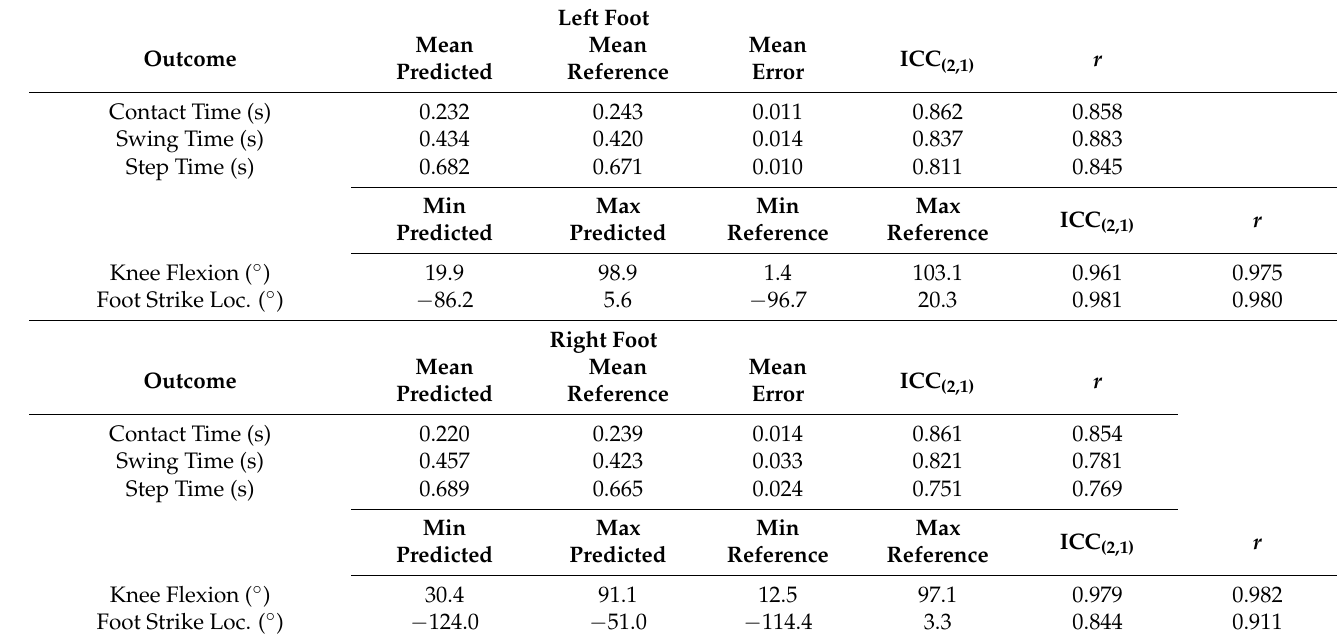
Table 1. Merged intraclass correlations (ICC (2,1) ), Pearson’s correlation, mean and mean error scores for the range of outcomes for all running speeds obtained from the proposed pose estimation (predicted) approach in comparison with 3D motion tracking reference data. In addition, min/max predicted and reference knee flexion angle and foot strike location are